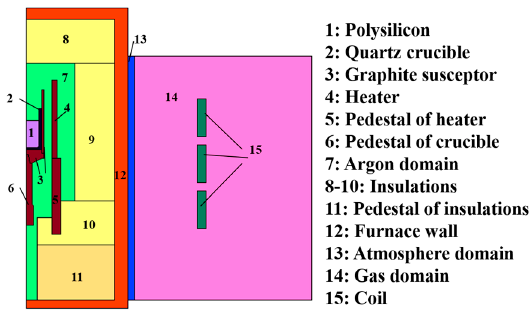
Figure 1. Schematic diagram of the directional solidification system.